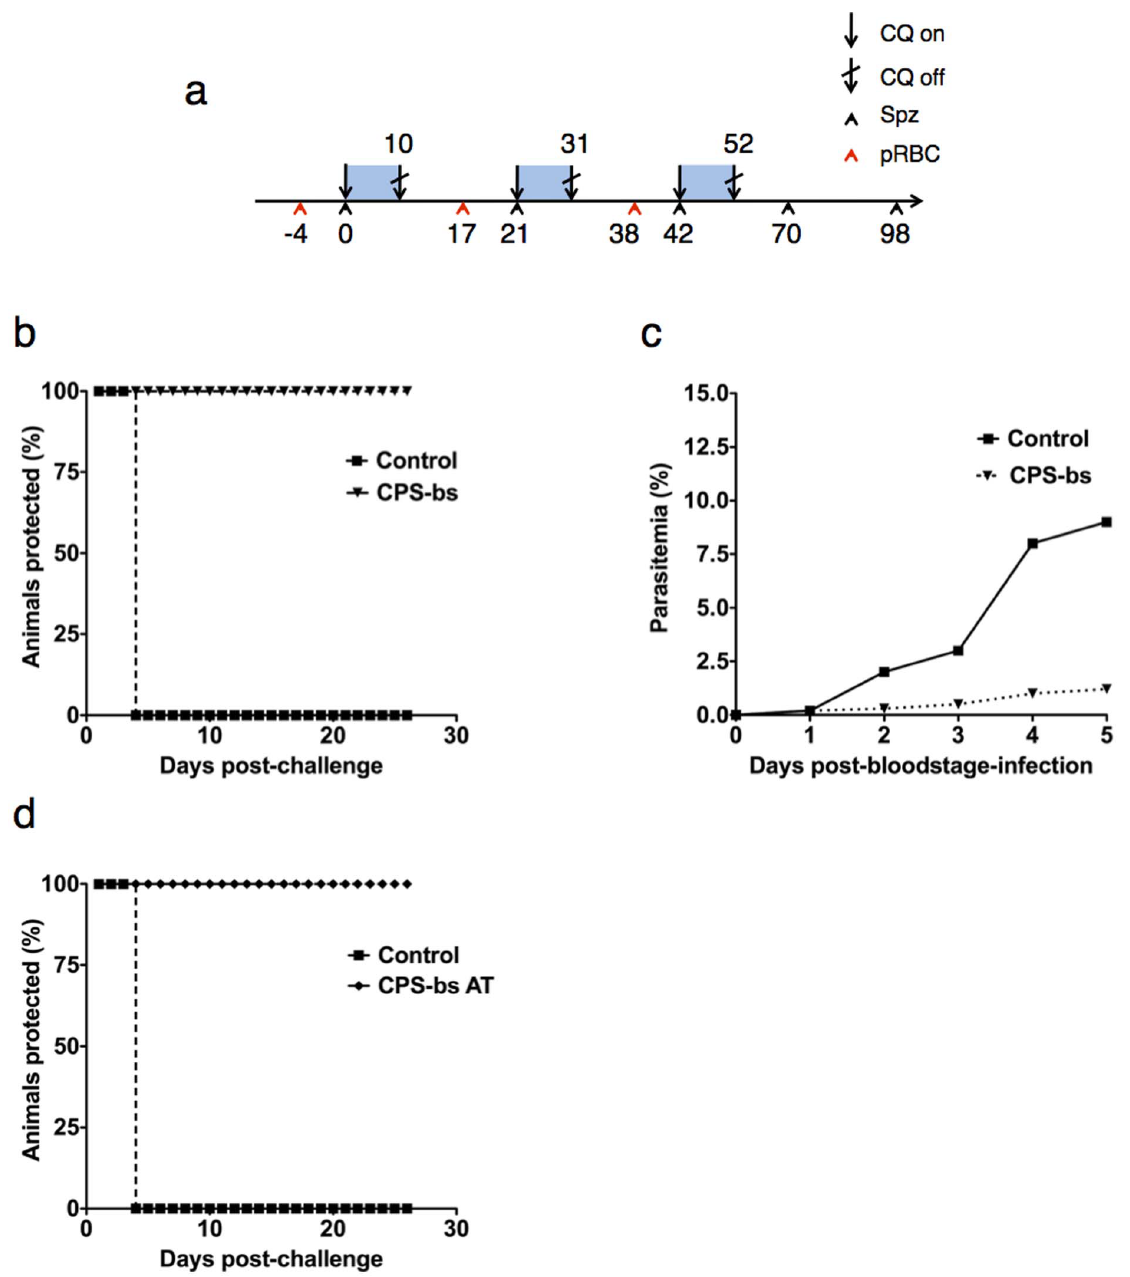
Figure 3. Figure 3a.Scheme to illustrate the CPS-bs immunization regime. Animals were subjected to three immunization shots of 10,000 Pb NK65 sporozoites at days 0, 21 and 42. Immediately after each immunization animals were administered chloroquine ad libitum for 10 days. Blue blocks represent periods of time under chloroquine cover. Animals were subjected to challenge with either 1 6 10 6 pRBC or 10,000 sporozoites at day 70 and, in some cases, rechallenged at day 98. Those animals in the CPS-bs groups were subjected to infection with 1 6 10 6 pRBC 4 days prior to each sporozoite immunization, at days 2 4, 17 and 38 as indicated. Figure 3b. CPS vaccination in patent animals generates sterilizing immunity with no apparent downregulation of immunity. Animals (n=5) were subjected to CPS under patency (CPS-bs) as described and subsequently challenged with 10,000 NK65 sporozoites at day 70 post-first-immunization. Naı¨ve age-matched animals in the Control group were challenged with 10,000 NK65 sporozoites only. Animals were monitored for presence of blood-stage parasitemia via Giemsa staining of daily blood smears. Figure 3c. CPS-bs vaccination partially inhibits blood-stage growth but does not protect against blood-stage challenge. Animals (n=5) were subjected to CPS under patency (CPS-bs) as described and subsequently challenged with 1 6 10 6 parasitized erythrocytes. Naı¨ve age-matched animals in the Control group were challenged with 1 6 10 6 parasitized erythrocytes only. Animals were monitored for presence of blood stage parasitemia via Giemsa staining of daily blood smears. Figure 3d. Protective immunity can be transferred by adoptive transfer with no apparent downregulation of CPS immunity. Animals (n=5) were subjected to CPS under patency as described. CPS-bs animals were sacrificed and their splenic lymphocytes isolated and purified and transferred into naı¨ve recipient animals, ‘‘CPS-bs AT’’. Age-matched animals in the control group